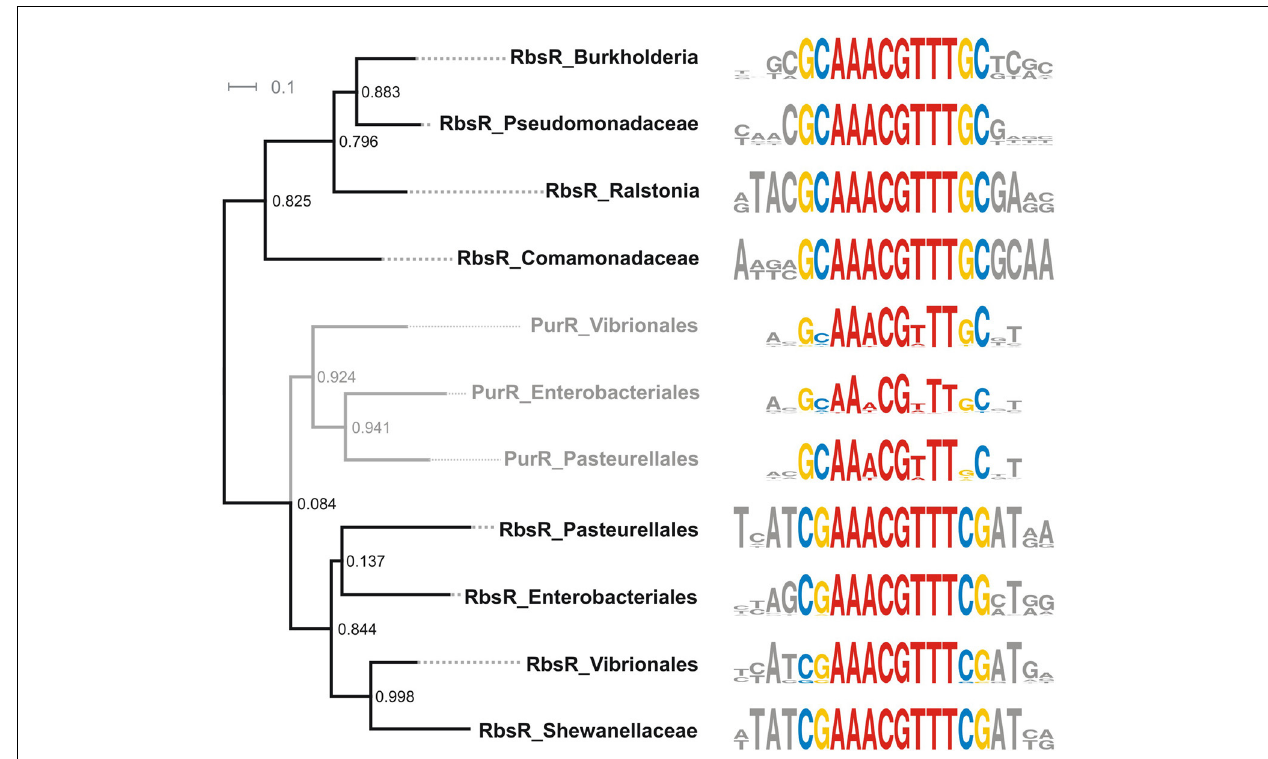
FIGURE 8 | Binding site motifs for PurR and RbsR from Beta- and Gammaproteobacteria. Positions conserved for all motifs are shown in red; branch specific positions are shown in blue (consensus C) and yellow (consensus G); non-conserved positions are shown in